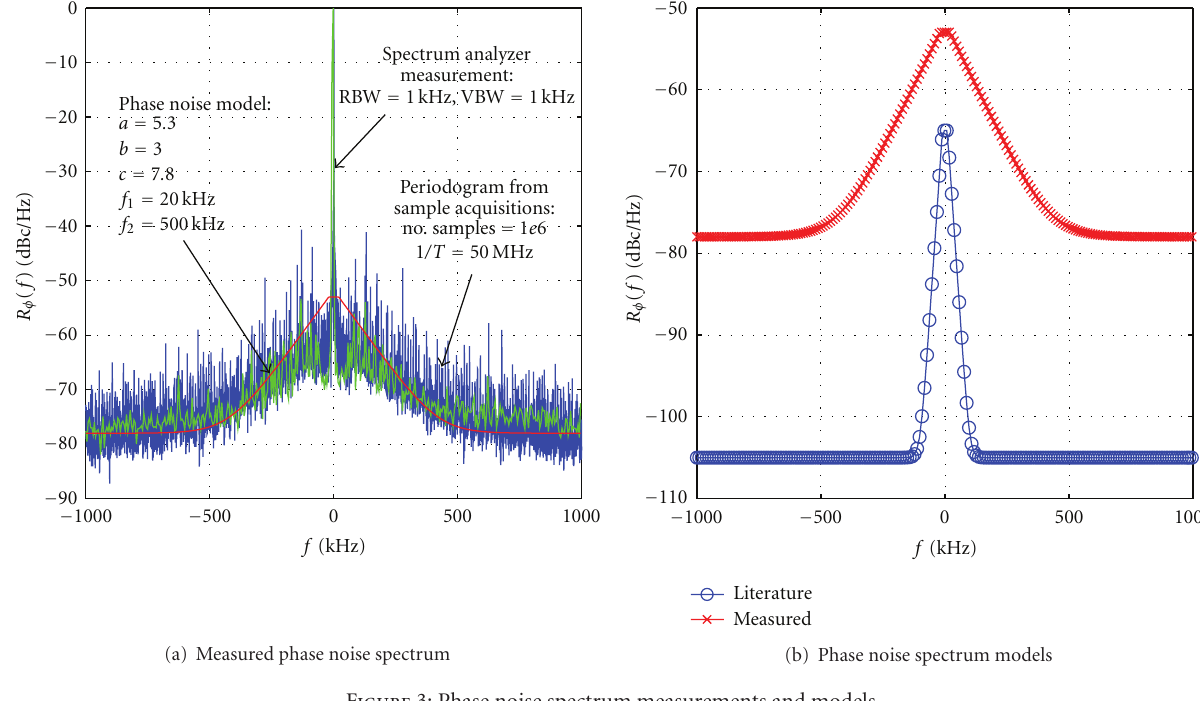
Figure 3: Phase noise spectrum measurements and models.